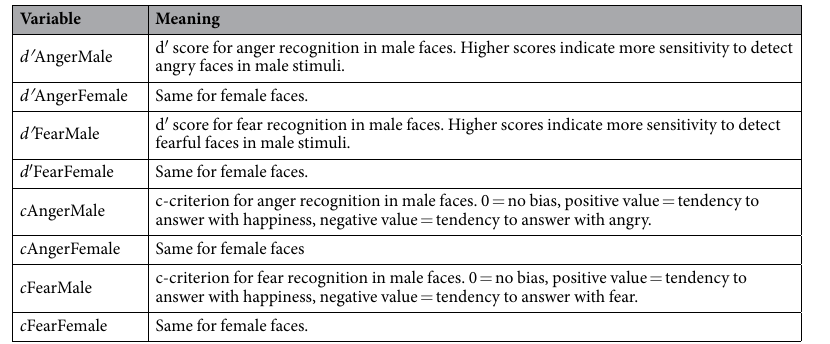
Variable Meaning